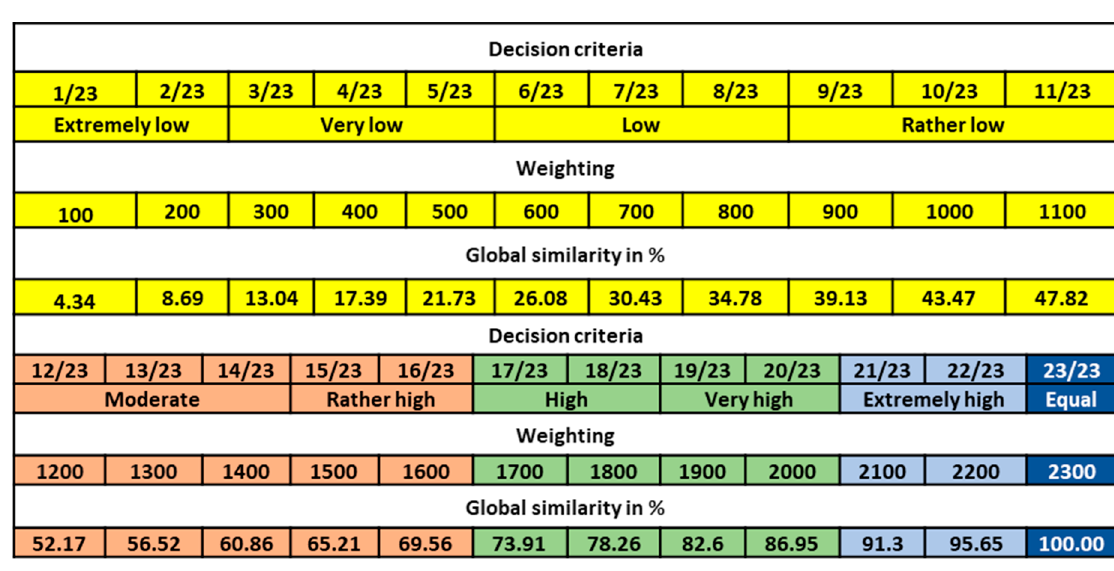
Figure 3. Decision criteria, weighting, and global similarities of pixels according to the ecological niche of species, a community of species, or landscape units.